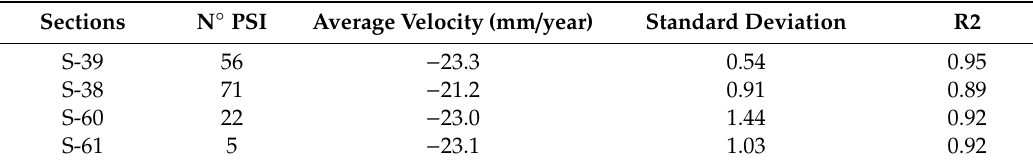
Table 3. Sections road subsidence of the A91